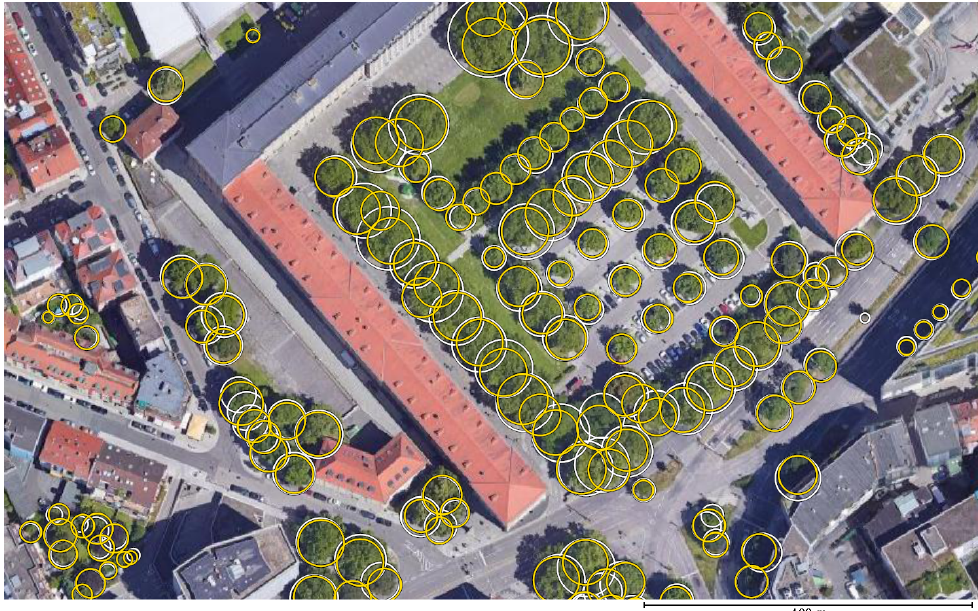
Figure 3. Exemplary detections from SCN-OD-RG in the test set. Yellow: predictions; white: ground